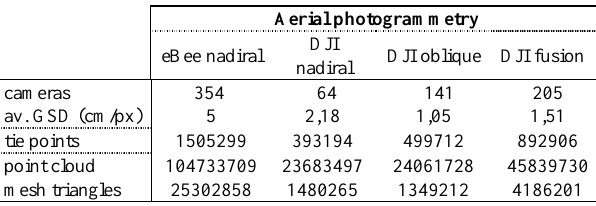
Table 3. Data processing results on aerial photogrammetry